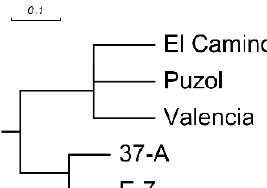
Table 2. Compounds quantified (mg/g dry weight) in fruit samples of pepino ( S. muricatum ) and its wild relative S. caripense samples by HPLC-DAD.